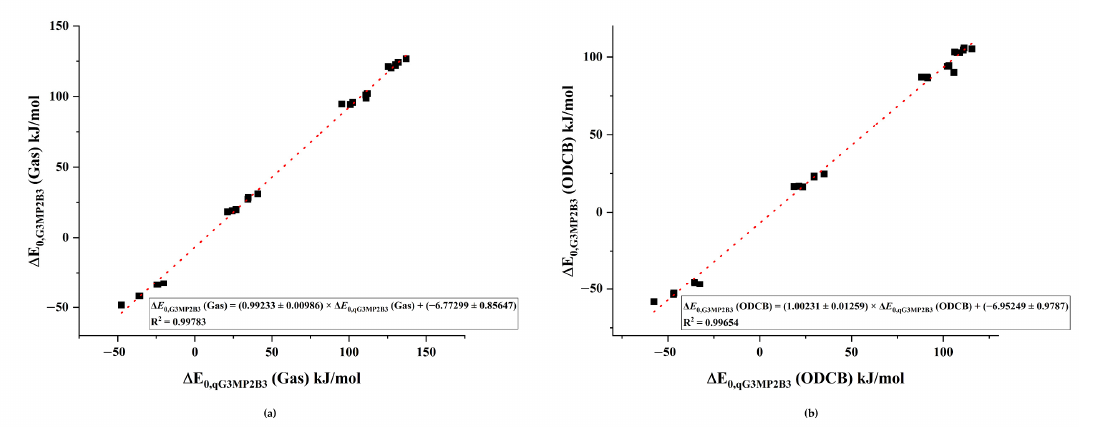
Figure 4. Comparison between the relative energies of the dimers computed using qG3MP2B3 and G3MP2B3 in the ( a ) gas phase and ( b ) ODCB. Fitted plots are marked by dotted lines.